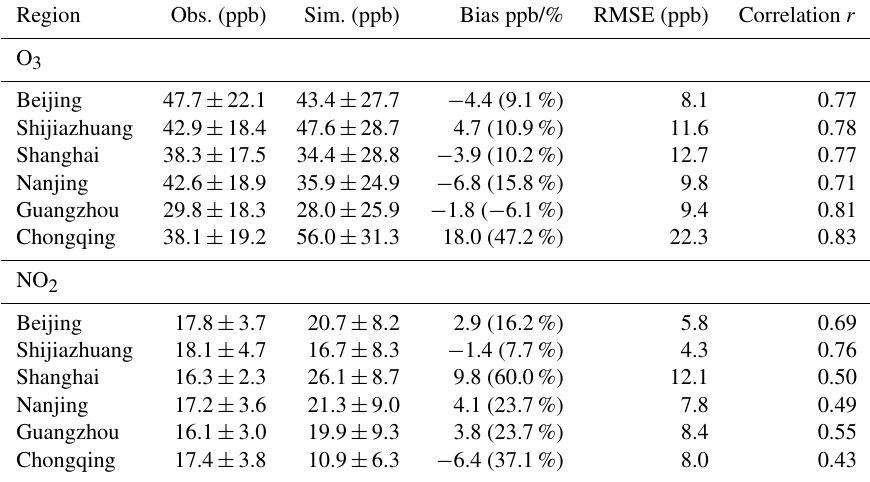
Table 2. Comparison of modelled and observed daily mean surface O 3 and NO 2 concentrations for the six industrial regions in JJA, 2016, China. Region Obs. (ppb) Sim.